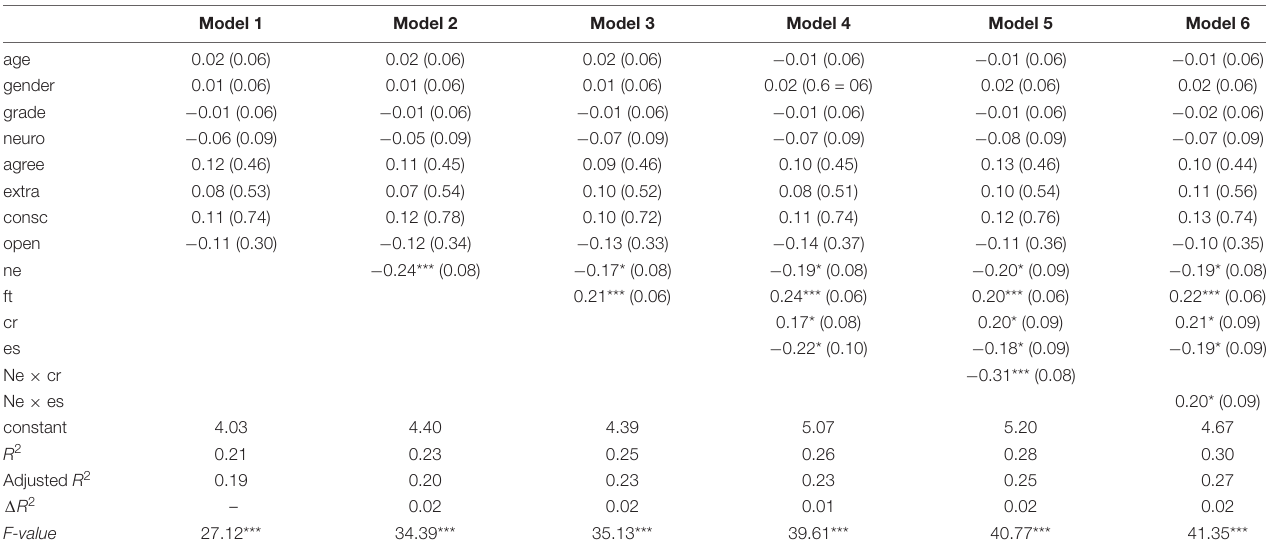
TABLE 2 | The results of hierarchical linear regression ( n =